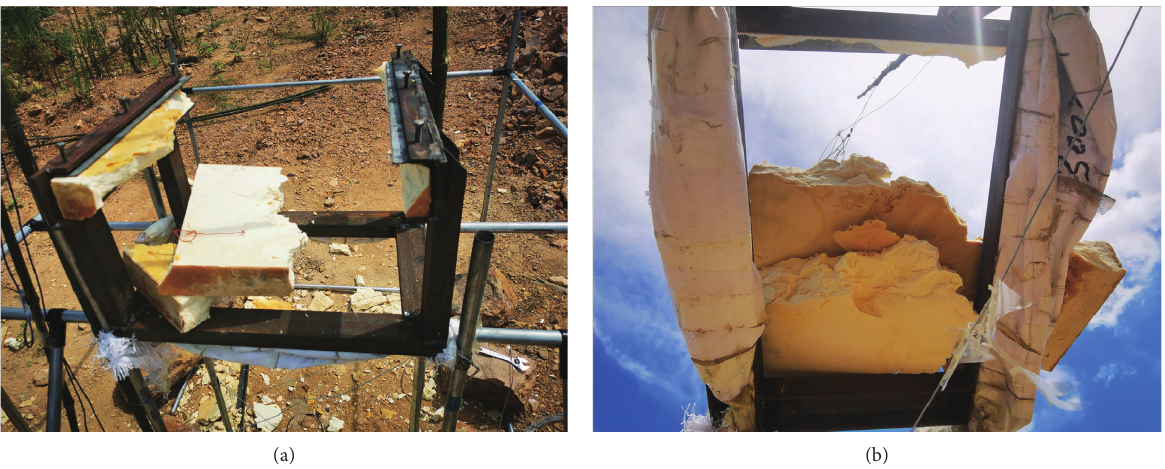
Figure 13: Test results of polymer slab B2 under 25 g explosive. (a) Top surface. (b) Bottom surface.